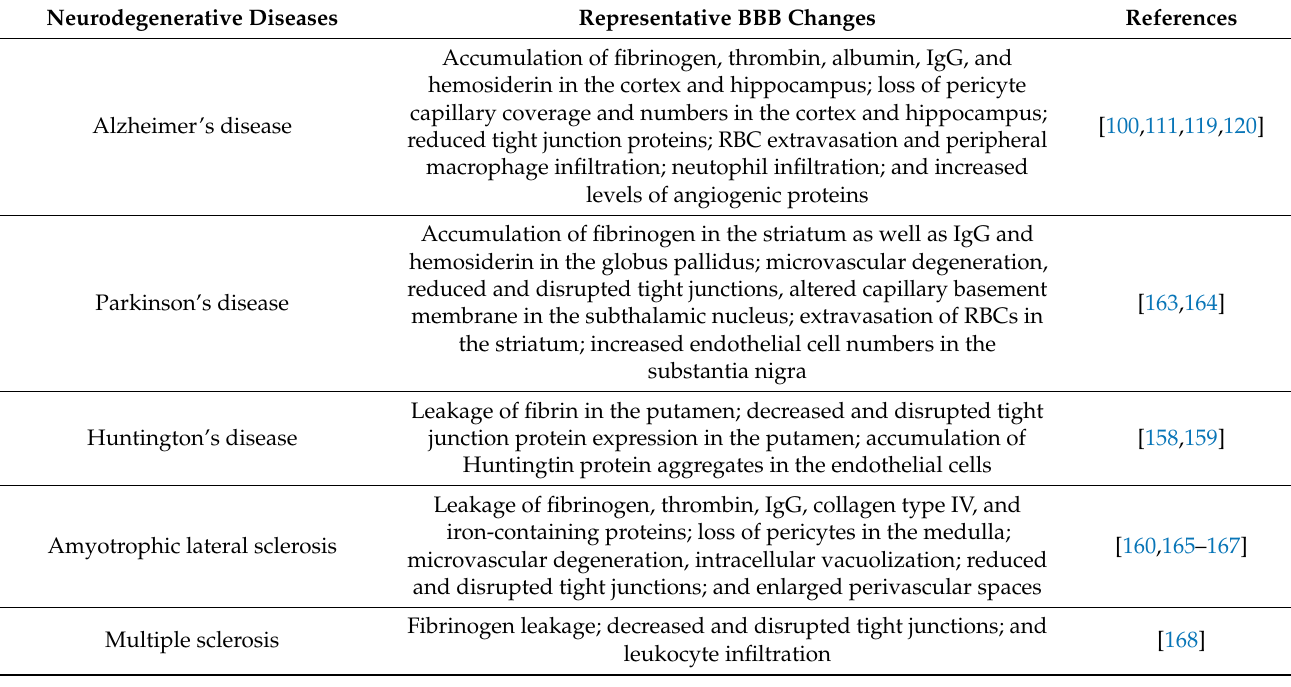
Table 2. Representative changes in BBB in neurodegenerative